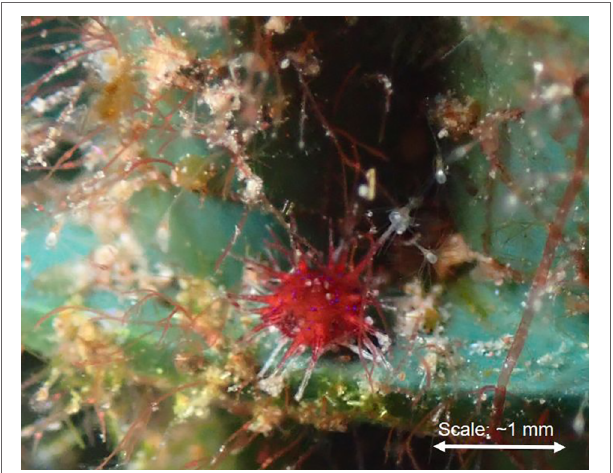
FIGURE 3 | D. antillarum settler on a bio ball.